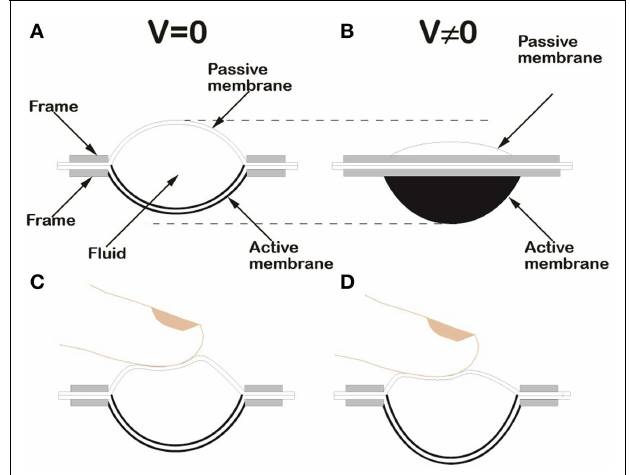
FIGURE 1 | Schematic drawing of the HC-DEA configuration used in this work . Lateral section of the device in the rest state (A) . Lateral view of the device in an electrically induced state, due to an applied voltage difference V (B) . Loading of the passive membrane of a bubble-like HC-DEA: the internal redistribution of the fluid ensures that the active membrane keeps a uniform profile, both at rest (C) and when a voltage is applied (D)